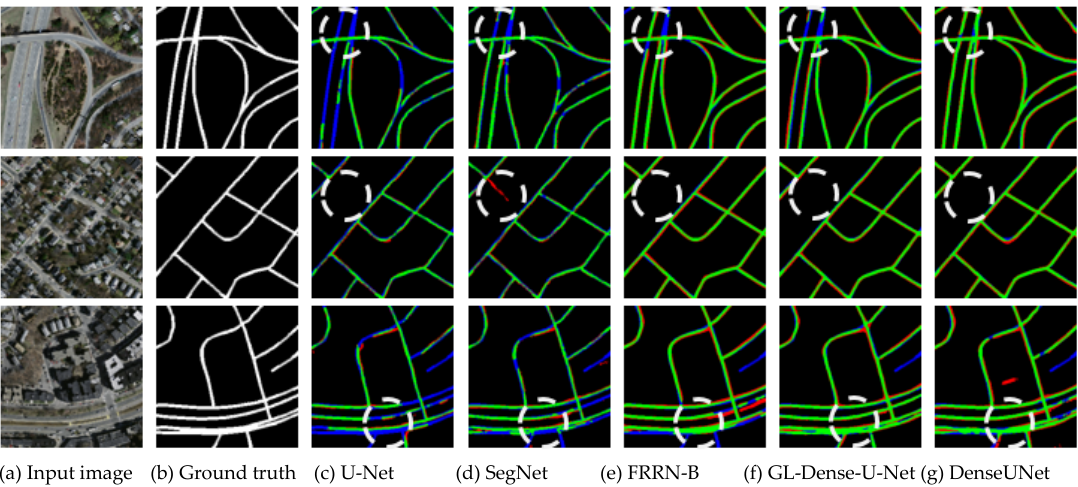
Figure 6. Images of the original actual color composite image are displayed and classified in three regions using deep learning methods. True positive (TP), false negative (FN) and false positive (FP) were marked as green, blue, and red, respectively.